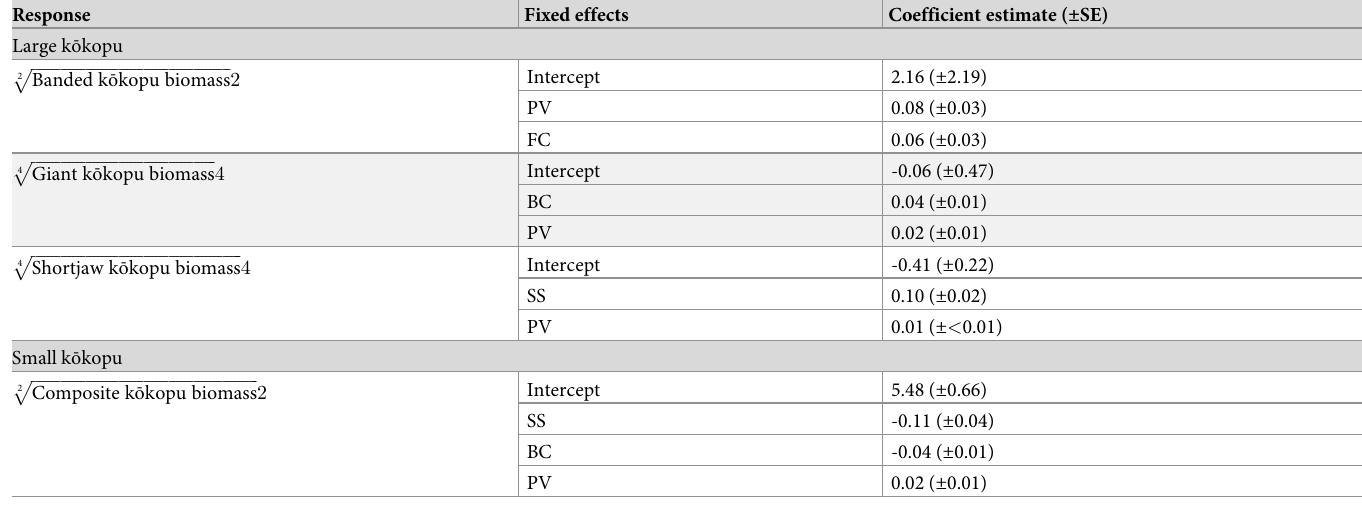
Abbreviations for habitat variables are the same as in Table